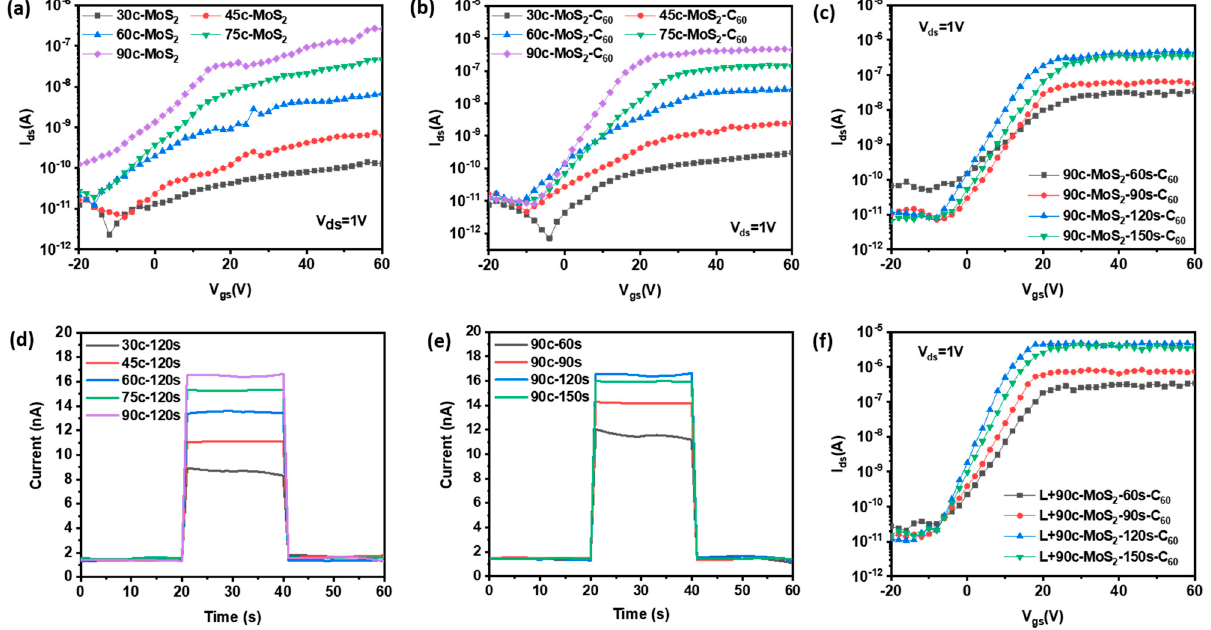
Figure 6. ( a ) FET transfer characteristic curve with different MoS 2 cycles; ( b ) 120s-C 60 -FET transfer characteristic curve with different MoS 2 cycles; ( c ) 90c-MoS 2 -FET transfer characteristic curve with different C 60 evaporation duration; ( d ) Photoelectric characteristics of 120s-C 60 channel materials with different MoS 2 cycles, ( e ) Photoelectric characteristics of 90c-MoS 2 channel materials